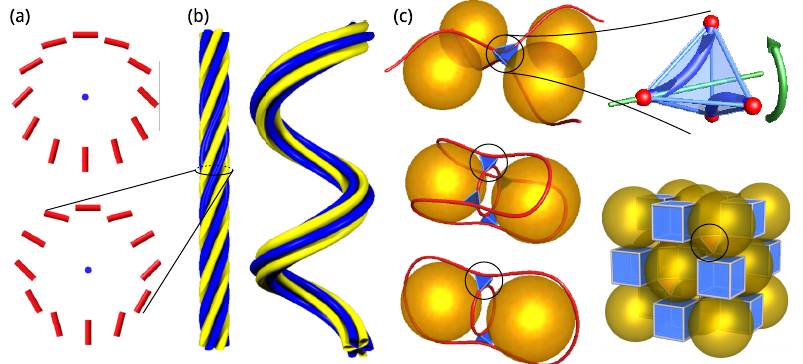
Figure 3. Topology of disclination lines. ( a ) Disclinations with planar cross sections with winding numbers + 1/2 and − 1/2. ( b ) Disclination lines with − 1/2 can twist or writhe, accumulating self- linking Sl when closed into a loop. ( c ) Disclinations can be reconfigured in three different ways at possible selected rewiring sites, which can emerge in different nematic colloidal